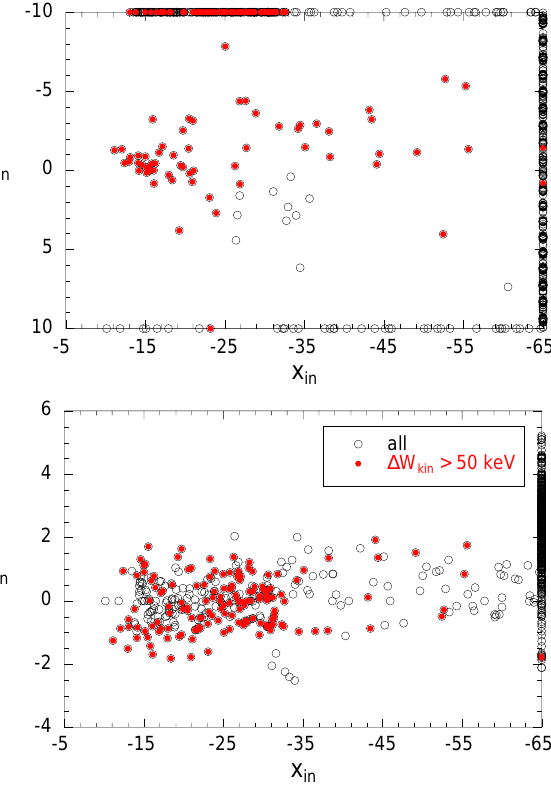
Fig. 13. Origins of the O + ions contributing to the tailward fluxes in the distant tail. The open circles represent the origins of all orbits contributing to Fig. 9, while the circles filled with red correspond to orbits with an energy gain above 50keV, indicating the sources of accelerated ions contributing to the regions of enhanced flux. These particles come primarily from the dawn boundary and the interior tail. The plot boundaries are also the simulation boundaries, where the backward integration of orbits was stopped. This is the reason why many symbols line up along these